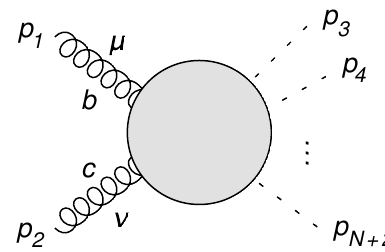
Figure 2 . The amplitude for the production of N colour-singlet particles from a pair of gluons, without (cid:12)nal state QCD